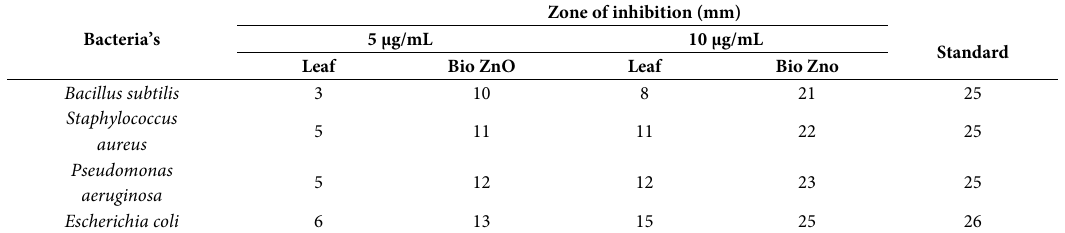
Table 3. Antibacterial activity of Acalypha indica leaf extract and biosynthesized ZnO nanoparticles against human pathogenic bacteria